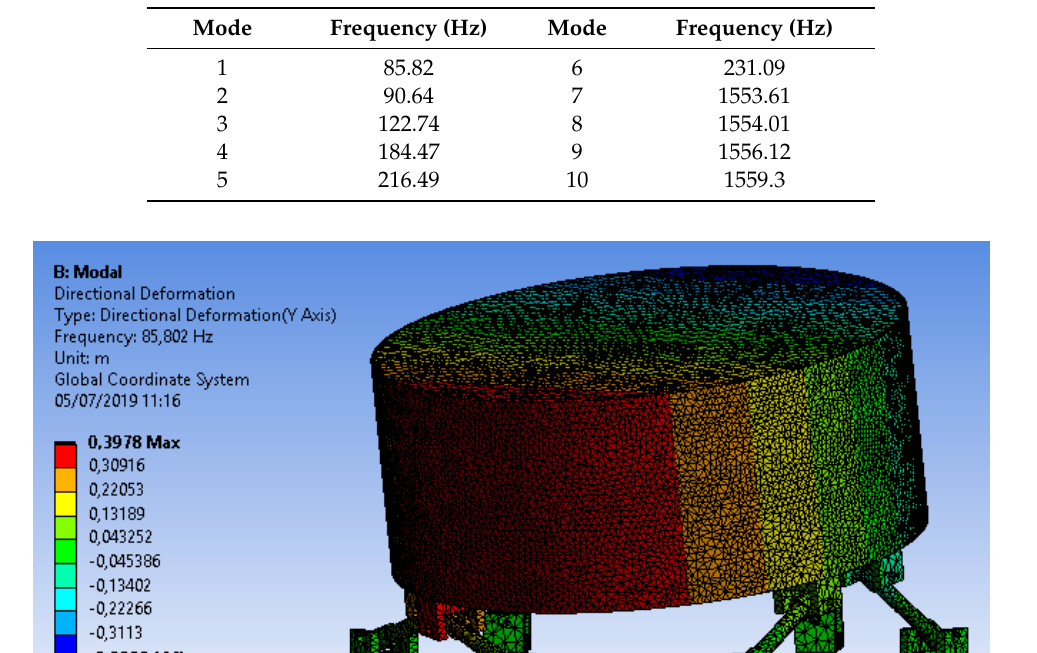
Table 4. The first 10 vibrational modes of the structure.